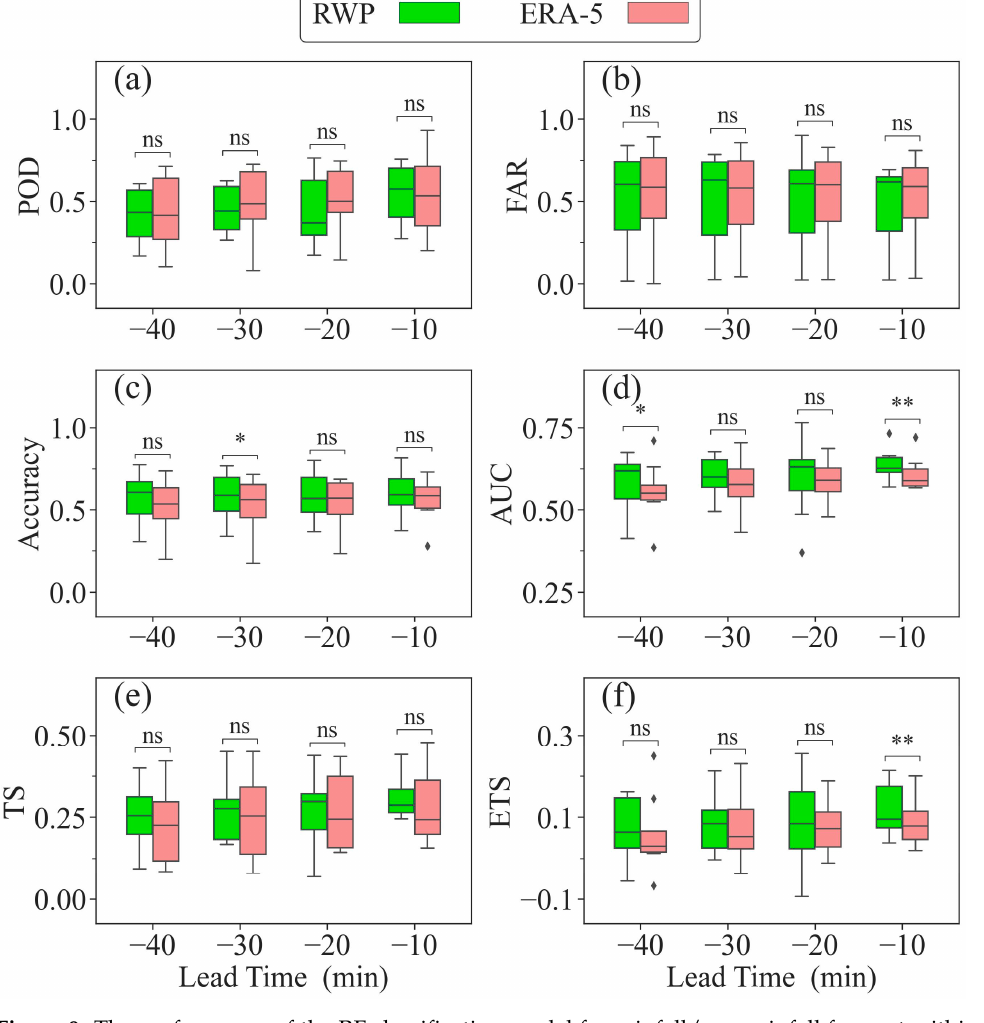
Figure 9. The performance of the RF classification model for rainfall/non-rainfall forecast within 30 min before the onset of rainfall, where the input features of D, ξ , and ω are from the RWP (in green) and ERA-5 (in pink), respectively. The evaluation metrics include POD ( a ), FAR ( b ), accuracy ( c ), AUC ( d ), TS ( e ), and ETS ( f ). * and ** above the box plot represents statistical significance passing the 95% and 99% confidence level, whereas “ns” represents no statistical significance, and outliers are indicated by black dots.